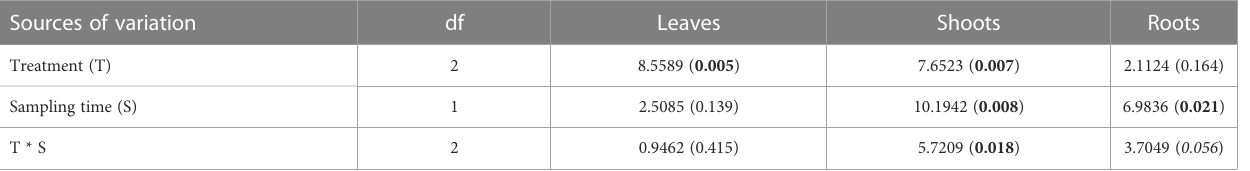
TABLE 1 Effects of treatment (control, xylem infusion, phloem infusion) and sampling date (3 weeks and 10 weeks after the infusion started), and their interaction on d 13 C values in leaves, shoots and roots of bonsai Ficus microcarpa trees, using the linear mixed-effects models. Sources of variation